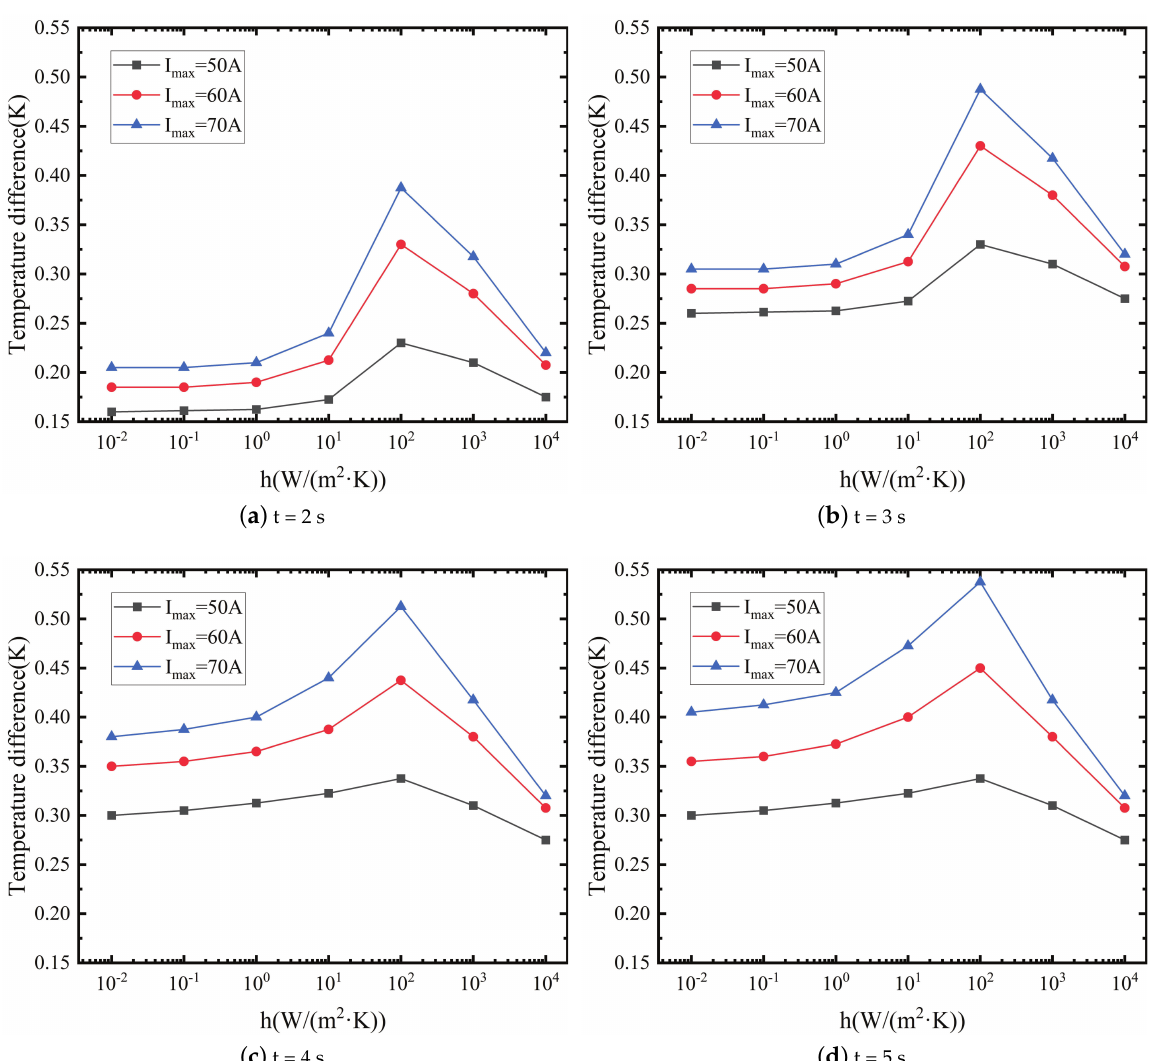
Figure 8. The time evolutions of the temperature difference inside the